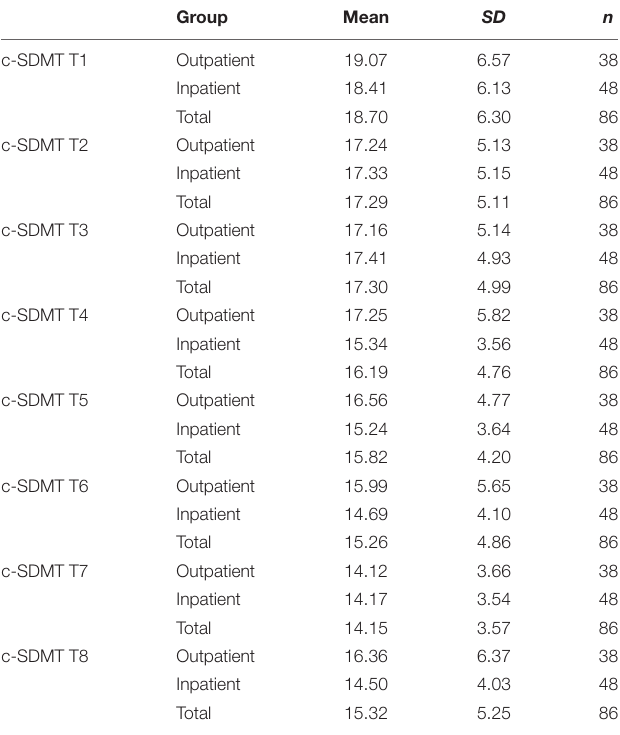
TABLE 4 | Descriptive statistics trials 1–8 of the c-SDMT.